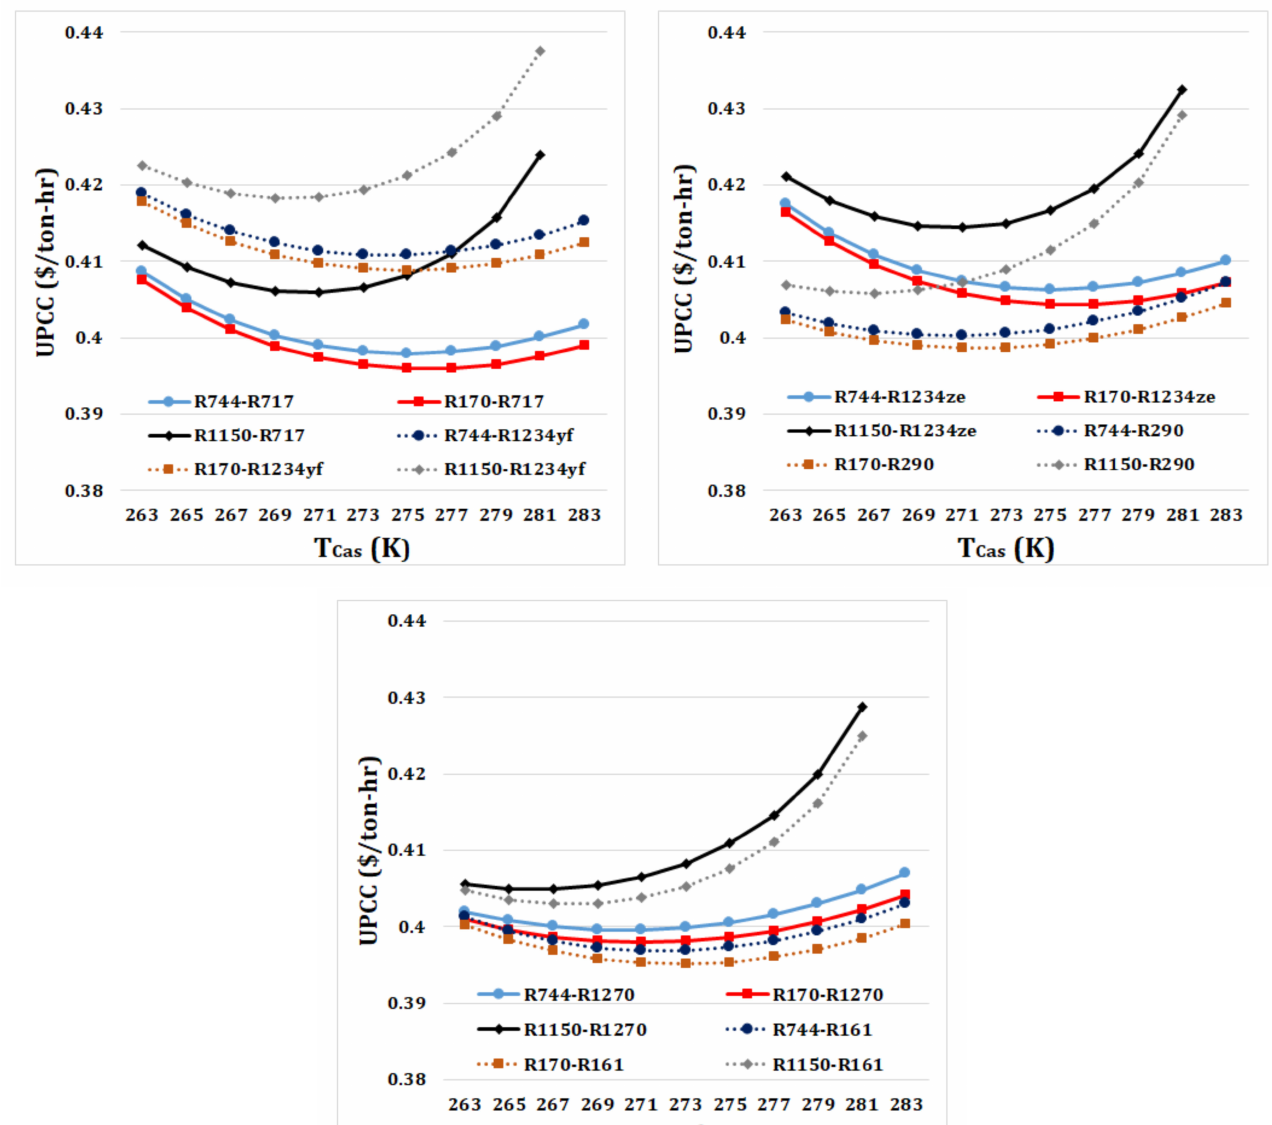
Figure 5. Effect of temperature of the cascade heat exchanger ( T Cas ) on the UPCC for different refrigerant